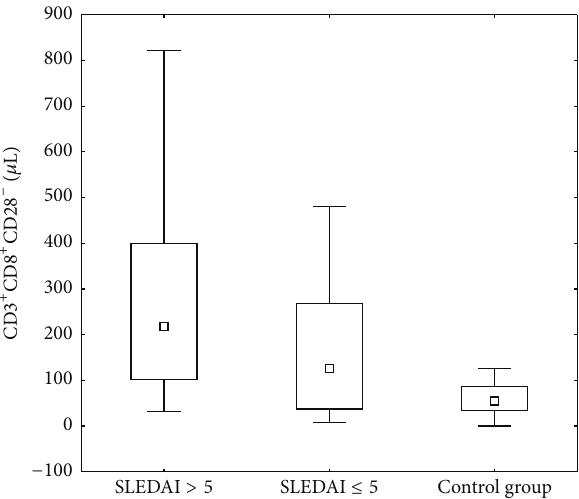
Figure2:ComparisonoftheabsolutenumberofCD 3 + CD 8 + CD 28 − cells in the patients divided into two groups according to disease activity measured by SLEDAI scale and the control group.